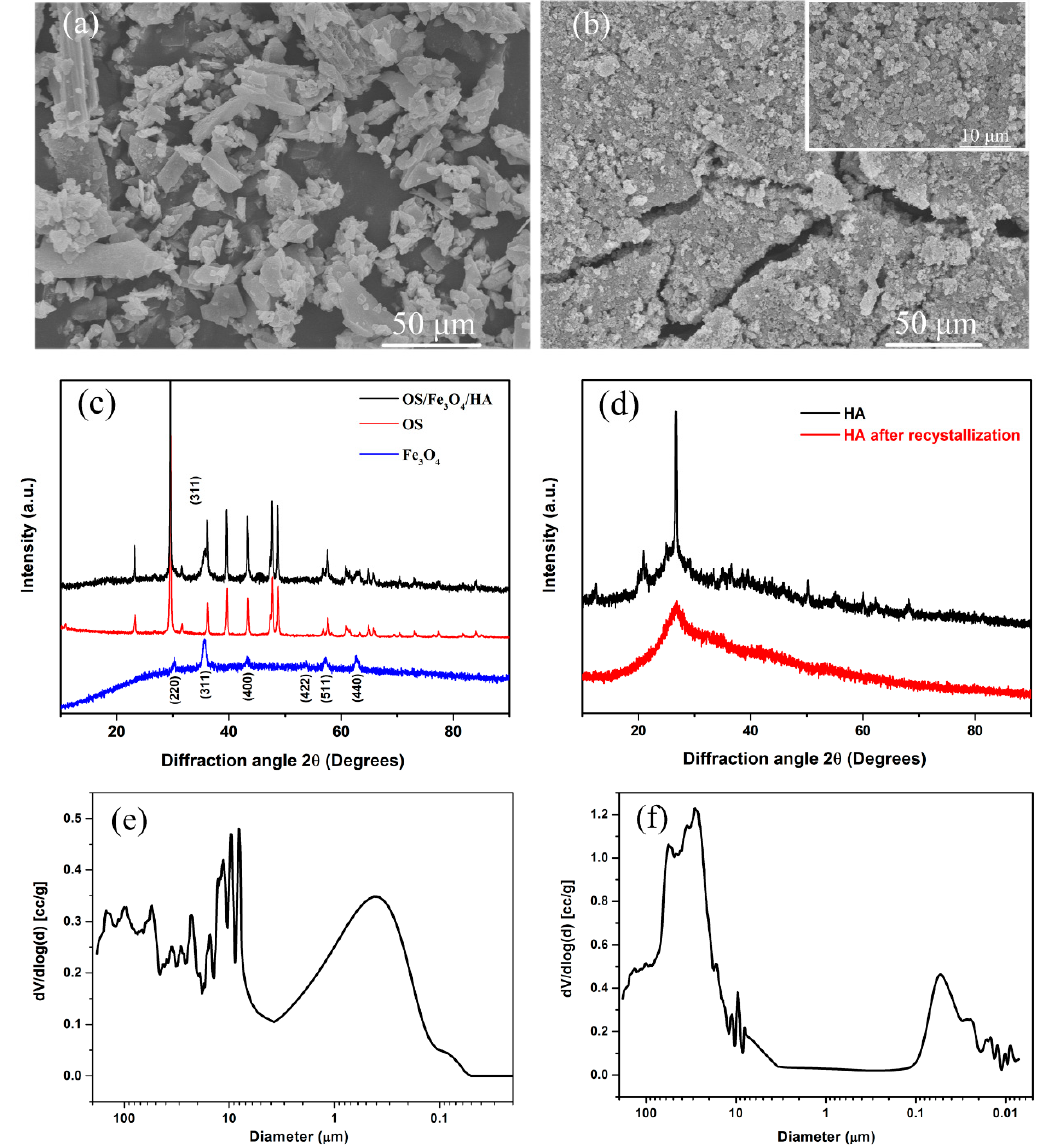
Figure 1. SEM images of ( a ) oyster shell (OS) and ( b ) OS/Fe 3 O 4 /humic acid (HA). X-ray diffraction (XRD) patterns of ( c ) OS/Fe 3 O 4 /HA and its constitutions of OS, Fe 3 O 4 , and ( d ) HA. Intrusion curves of ( e ) OS and ( f ) HA/Fe 3 O 4 /OS (Hg contact angle: 140°).